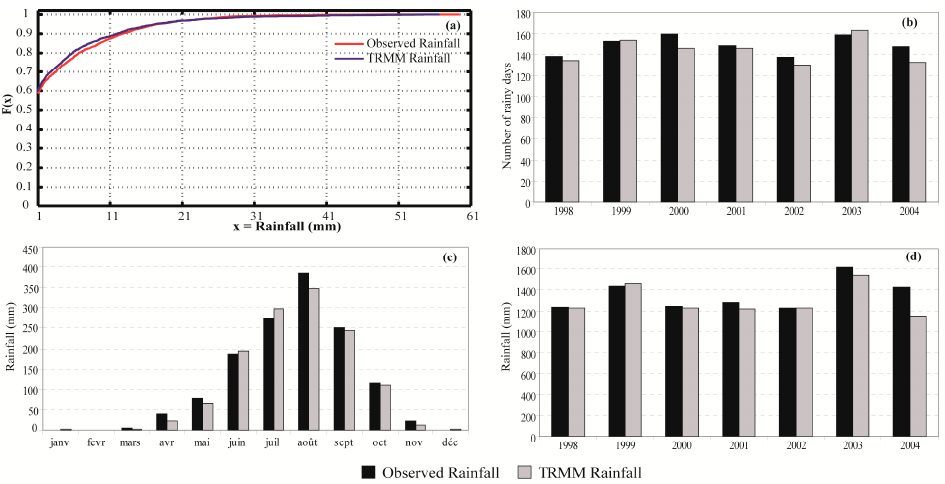
Figure 4. Comparison between mean observed and TRMM rainfalls: ( a ) cumulated frequency; ( b ) number of rainy days; ( c ) monthly rainfalls; ( d ) annual rainfall.